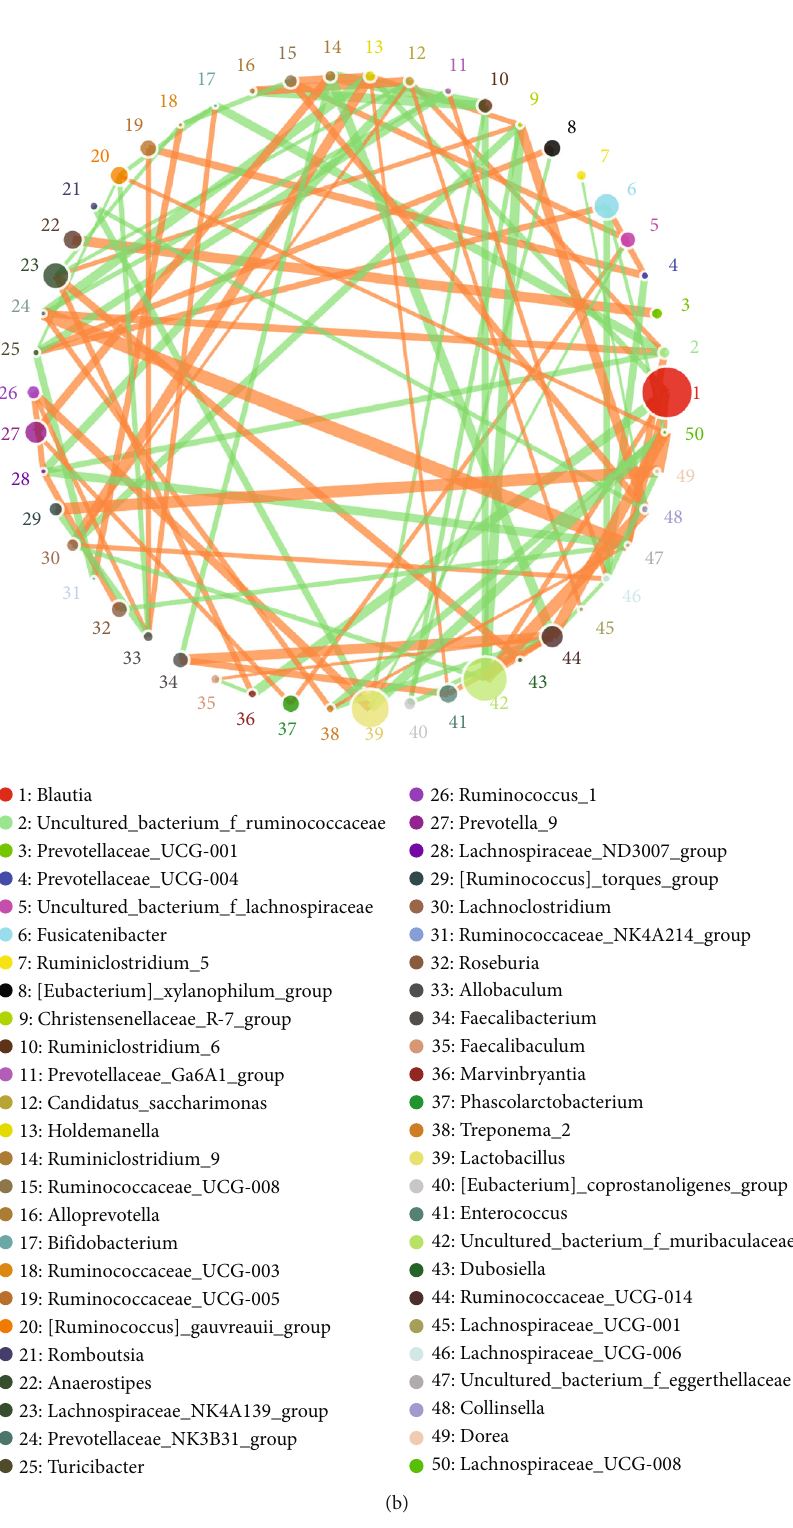
Figure 6: Correlation networks of the top 50 most correlated genera among the IBS-D and TCM treatment group microbial communities. (a) The IBS-D-associated network. Pearson ’ s correlation coe ffi cients among the centered log-ratio-transformed bacteria were calculated, and correlations with coefficients ≥ 0 : 4 and P values < 0.05 were retained. In the network, each node represents a bacteria at genus level. The node size is proportional to the mean relative abundance of the bacteria. The orange lines between the nodes show positive correlation, and the green lines show negative correlation. (b) The medium dose of TCM treatment-associated